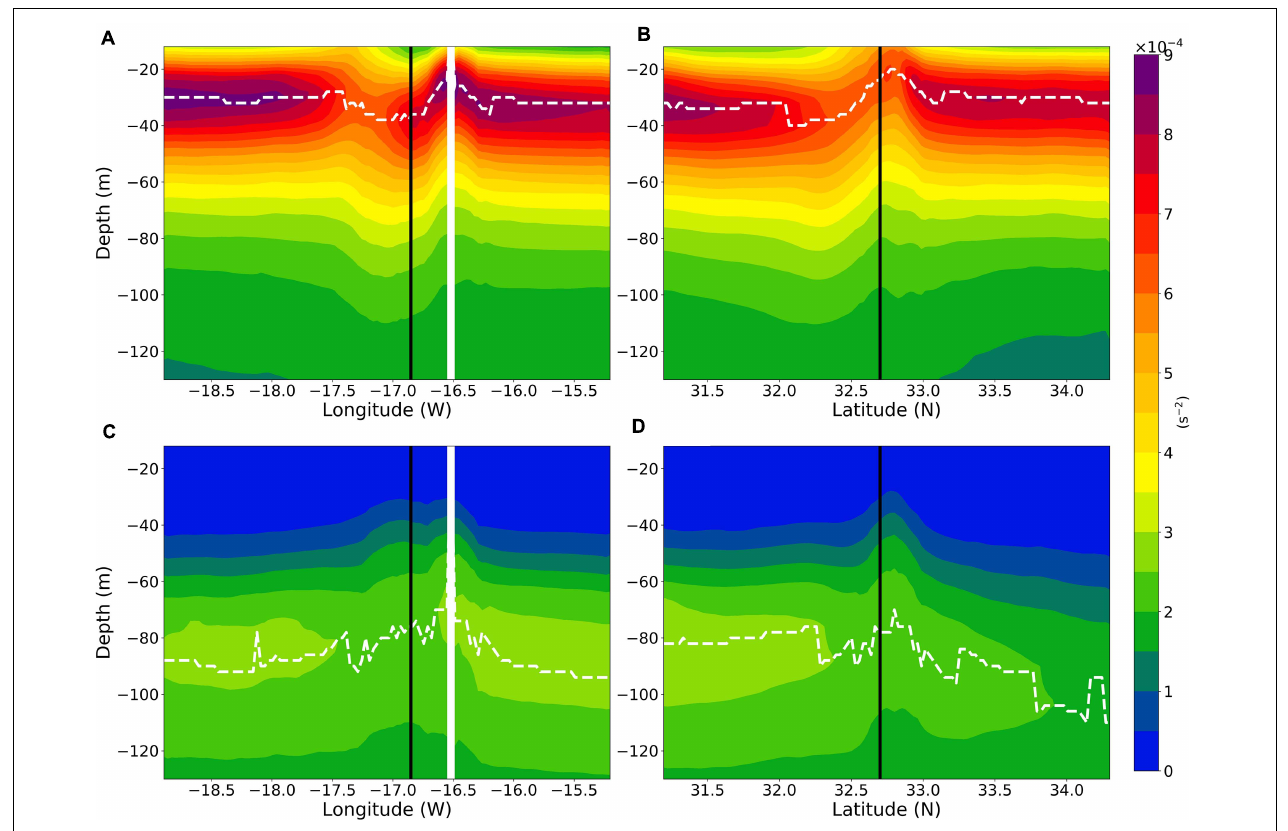
FIGURE 10 | Mean (1983–2017) ocean summer (JJA) cross-sections of squared Brunt–Väissälä frequency (s-2): (A) zonal section at 32.6N; (B) meridional section at 16.85W. Vertical black lines indicate location of maximum perturbed upper ocean. White bar in Figure 10A ) is due to Desertas island. White dashed line shows depth of maximum N 2 . (C,D) similar to (A,B) , respectively, but for winter (DJF).